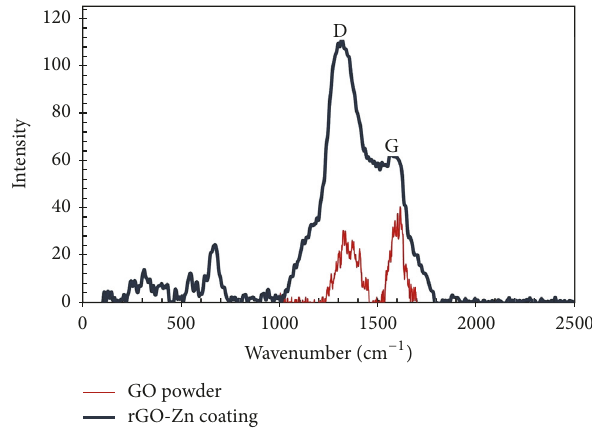
Figure 5: Raman spectra of the GO powder and rGO-Zn coating synthesized by pulse-potential electrodeposition approach.